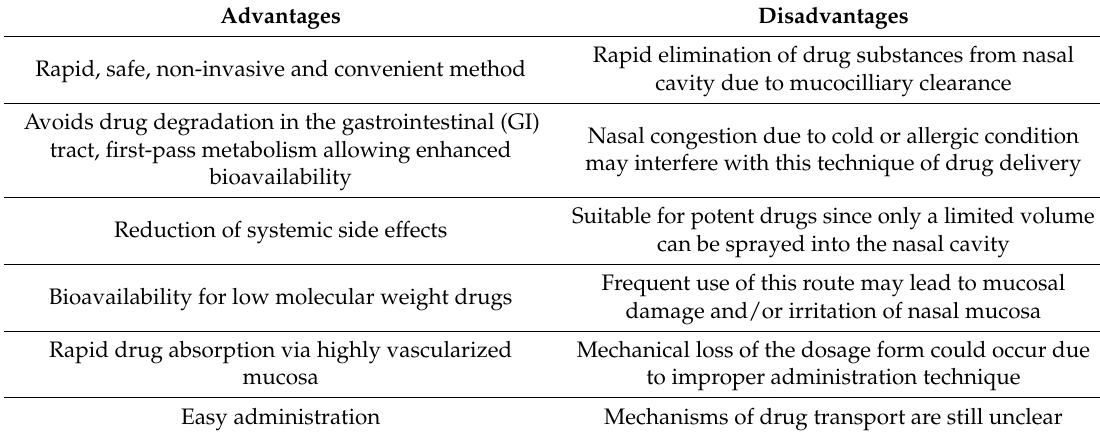
Table 1. Advantages and disadvantages of Intranasal (IN) drug